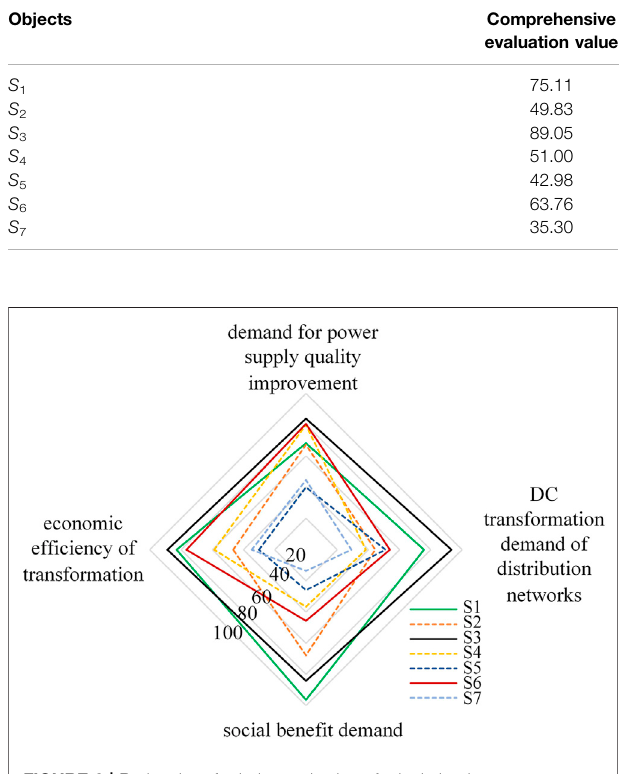
TABLE 2 | Comprehensive evaluation value of different objects.